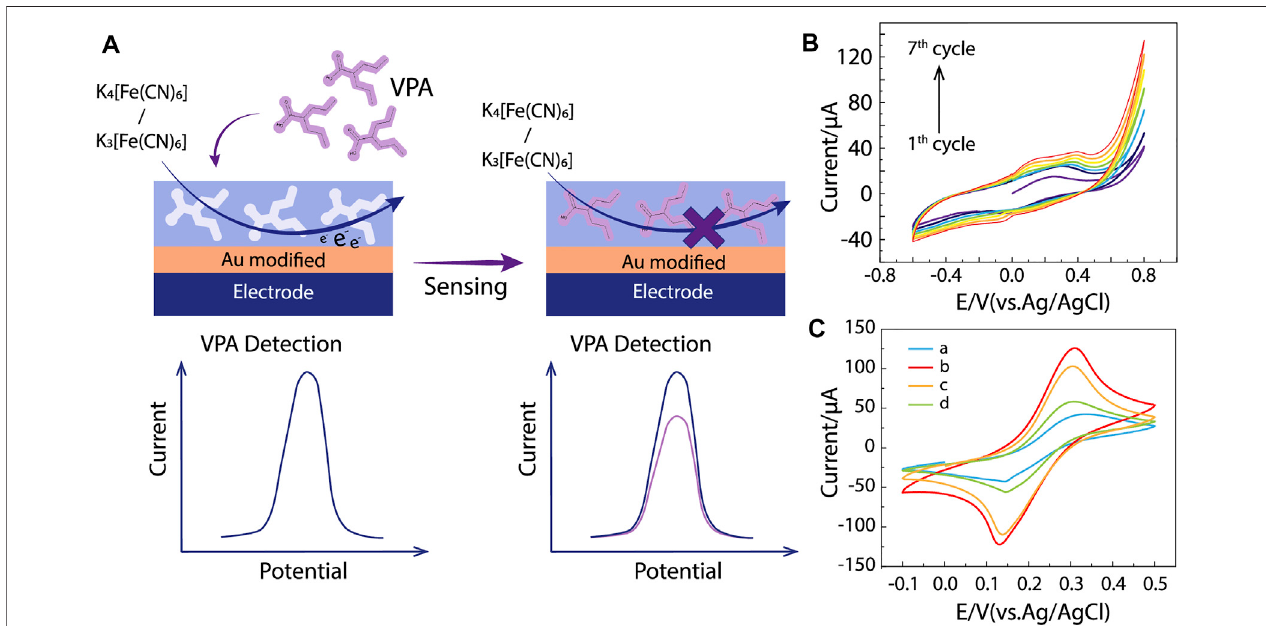
FIGURE3| MIP/gateeffectandelectrochemicalcharacterization. (A) ThemajorprincipleofMIP/gateeffect. (B) Cyclicvoltammogramofelectropolymerization ina solutioncontaining0.025 Mpyrrole,0.01 MVPA,and0.1 MLiClO 4 ,from − 0.6to0.8 V,atscanrate50 mV s − 1 (vs.Ag/AgCl). (C) CVresponsesof0.01 M[Fe(CN) 6 ] 3 − /4 − solution containing 0.1 M KCl at (a) bare SPE, SPEs modi fi ed with (b) ppy@AuNPs-MIP, (c) ppy@AuNPs-MIP incubated in VPA solution, and (d)